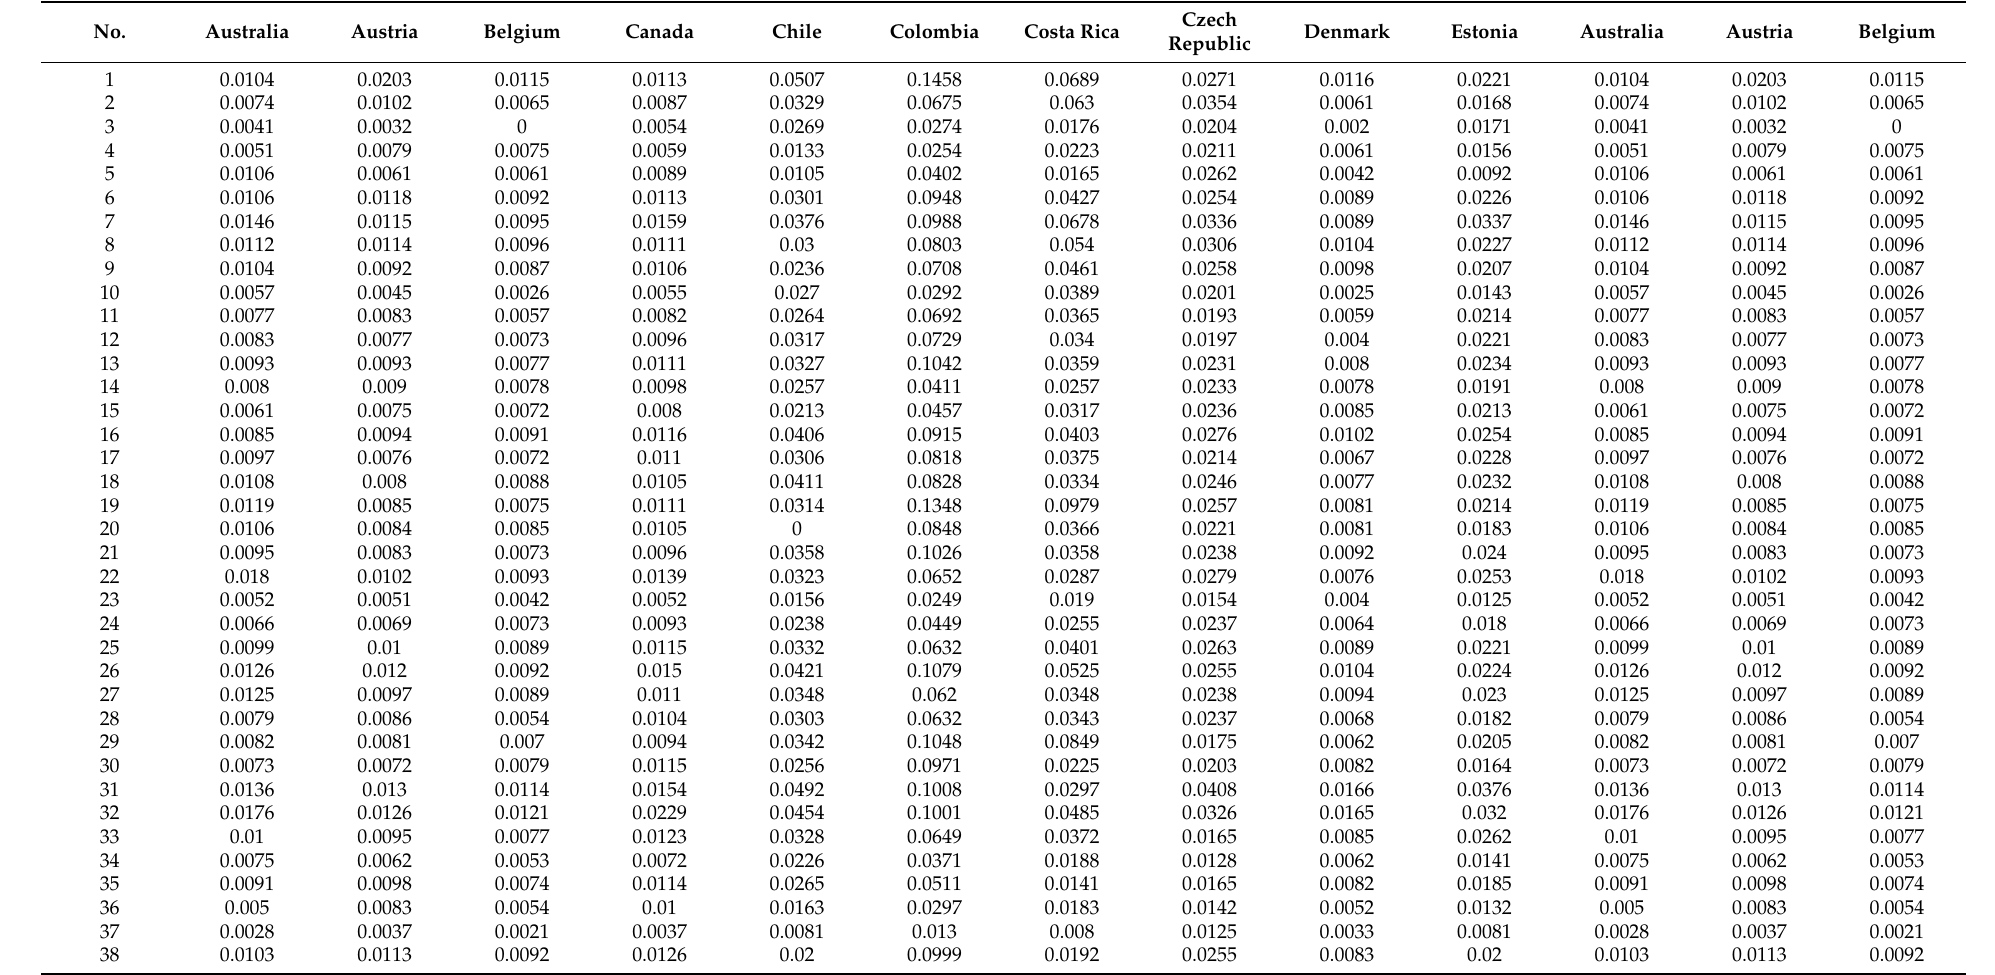
Table A1. Labour values per sector of the 38 OECD